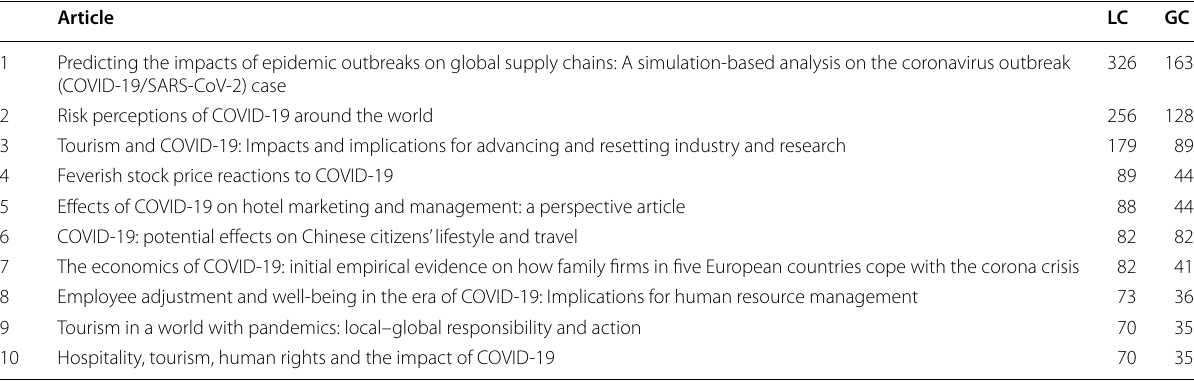
Table 7 Top 10 cited articles of Covid‑19 and Performance